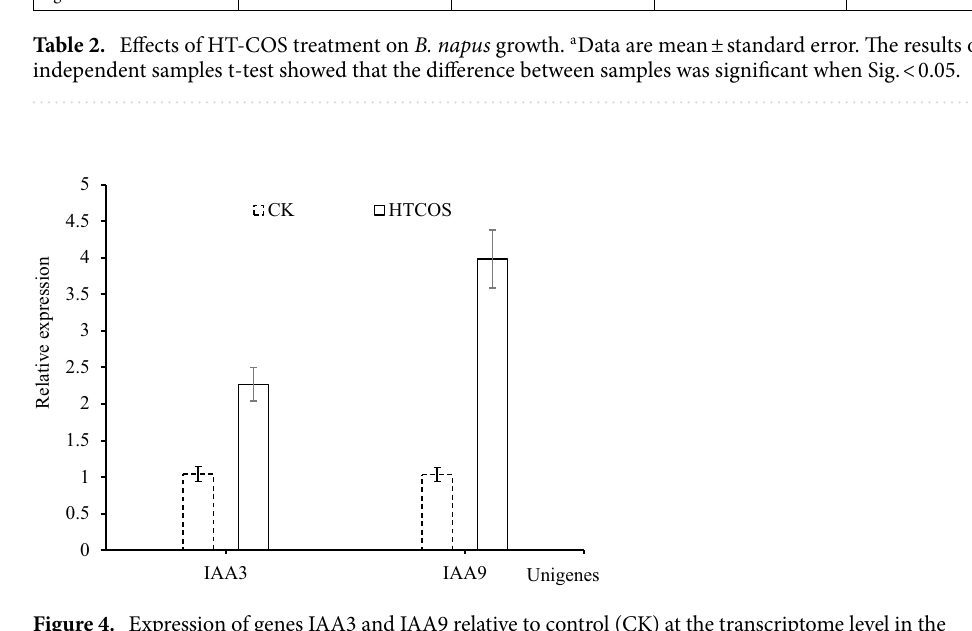
Figure 4. Expression of genes IAA3 and IAA9 relative to control (CK) at the transcriptome level in the HT-COS (DA) treated group and validation by qRT-PCR − ΔΔCt values.